Question: State the chart type depicted above.
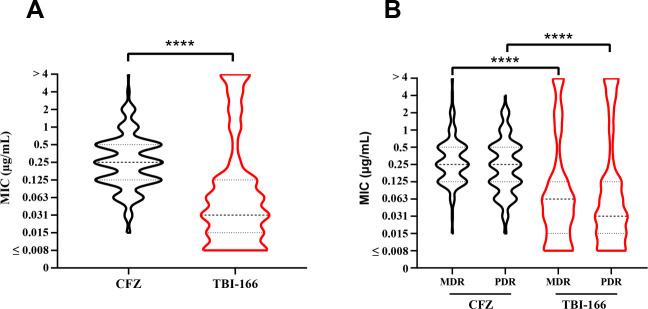
Answer: box